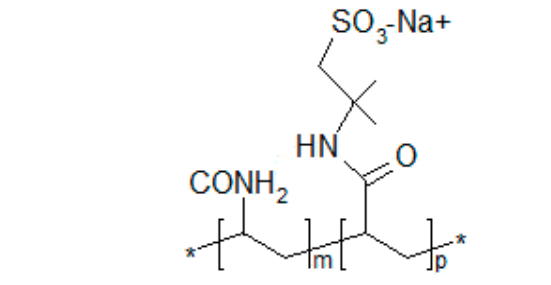
Table 2. Polymer characteristics.